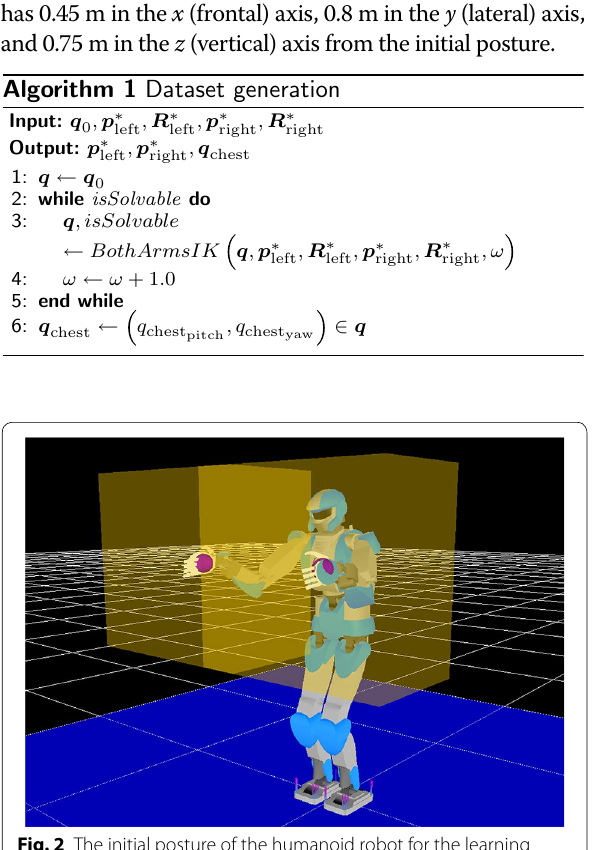
Fig. 2 The initial posture of the humanoid robot for the learning procedure, with yellow boxes indicating the humanoid’s workspace and purple spheres indicating the position of the end effectors